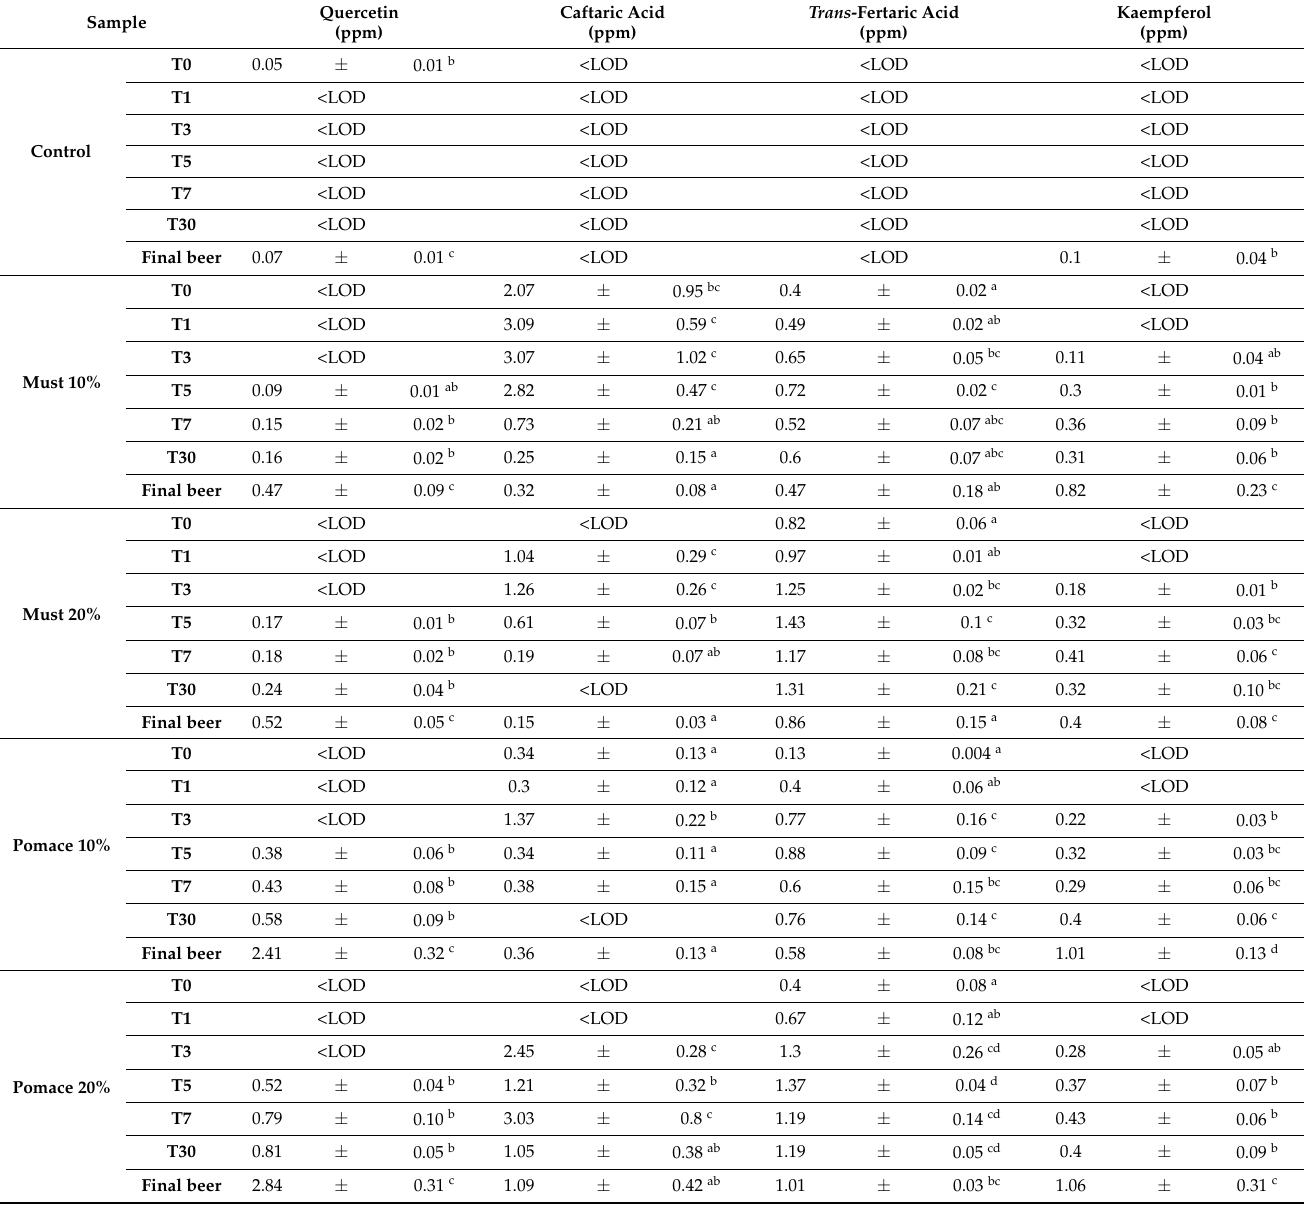
Table 2. Quercetin, caftaric acid, trans -fertaric acid, and kaempferol concentration in the different sub-samples collected from the starting of fermentation to the final